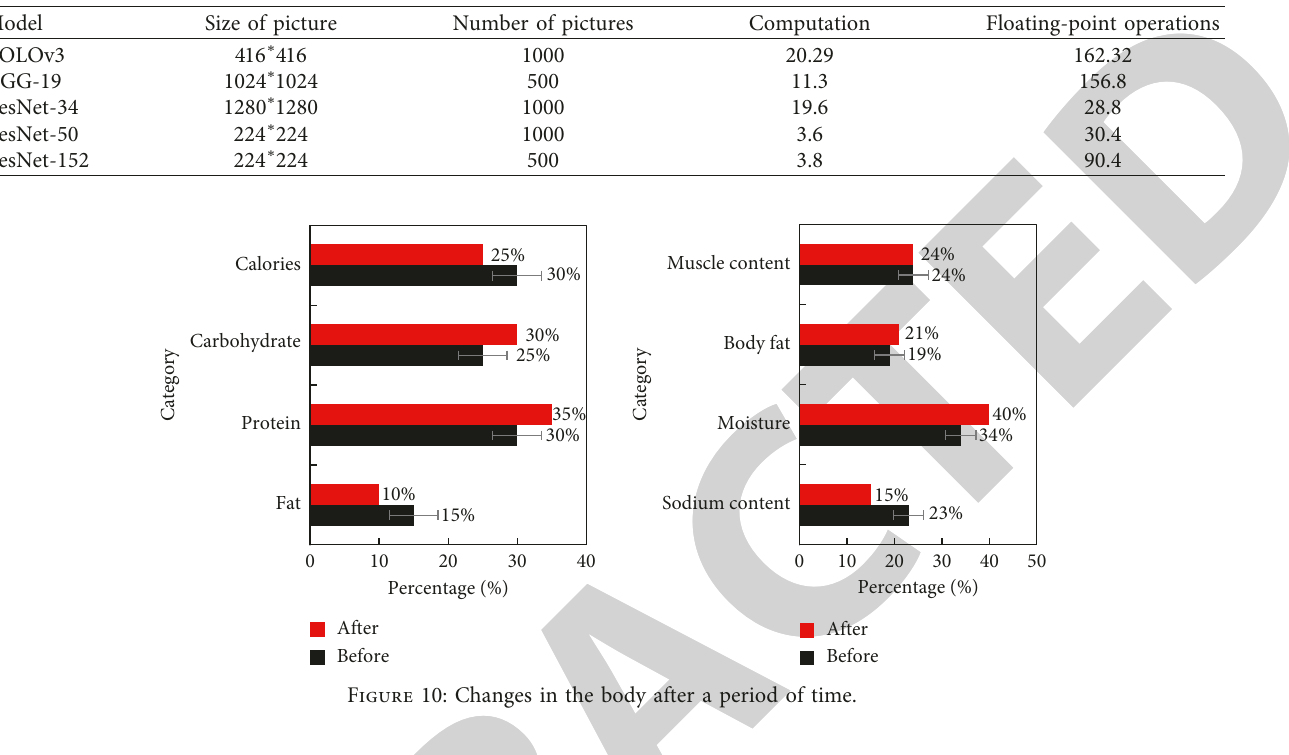
Table 2: Average power ratio of intelligent computing